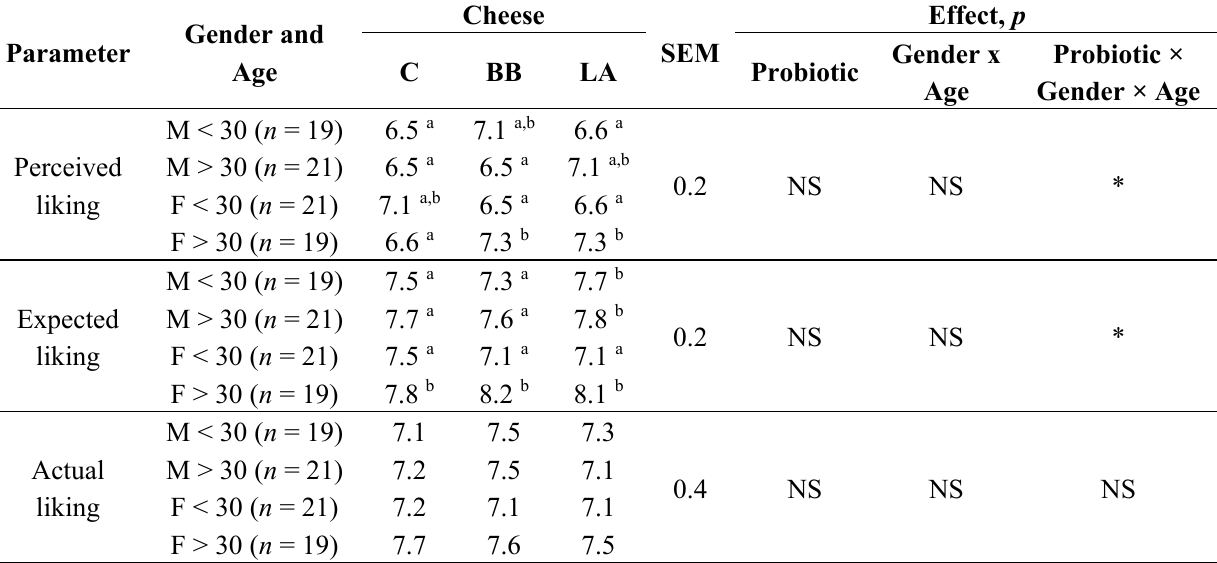
Table 4. Rating of probiotic ovine cheese